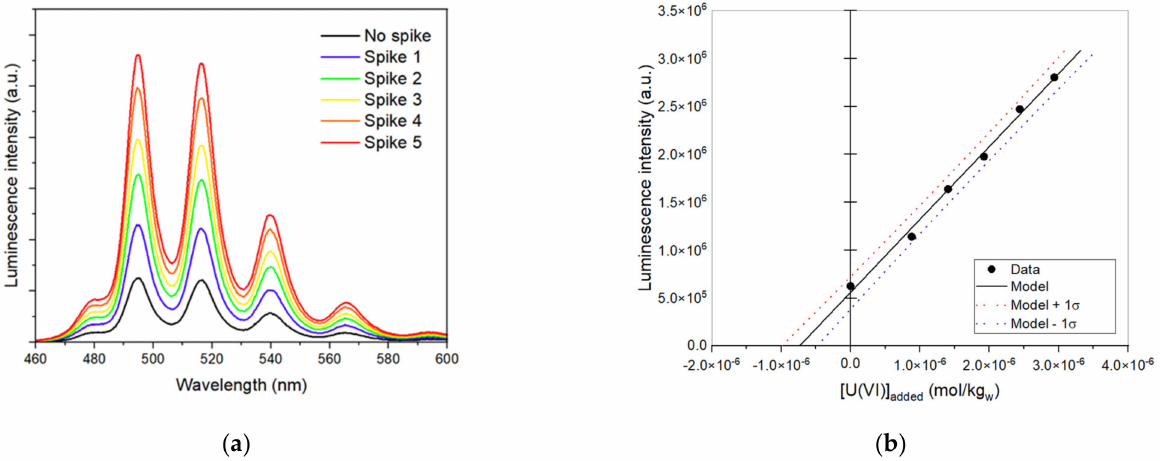
Figure 2. Luminescence spectra of U(VI) in 0.8 mol/kg w H 3 PO 4 as a function of U(VI) standard addition: ( a ) raw U(VI) luminescence spectra; ( b ) evolution of the intensity obtained for the peak at 495 nm as a function of the U(VI) standard